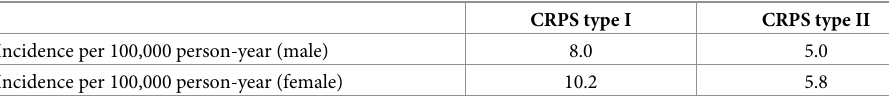
Table 1. Incidence of CRPS by patient sex in